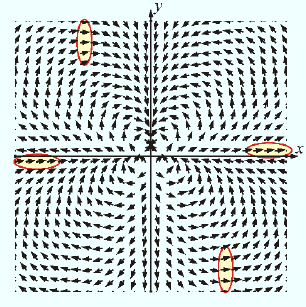
Figure 7. Jones vectors of a first-order optical vortex ( m = 1) with a third-order polarization singularity ( n = 3).